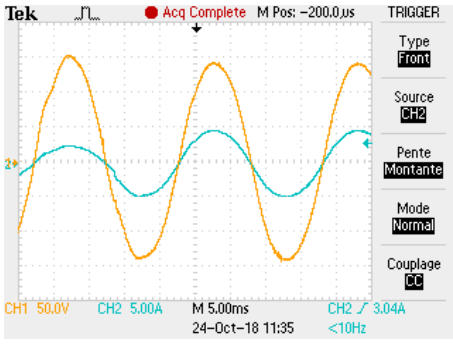
Figure 12. Input voltage at 90 V and load changes suddenly (from 60 Ω to 30 Ω ). Experimental waveforms of v o (CH1: Time (5 ms/div), v o (50 V/div)) and I o (CH2: Time (5 ms/div), I o (5 A/div)).